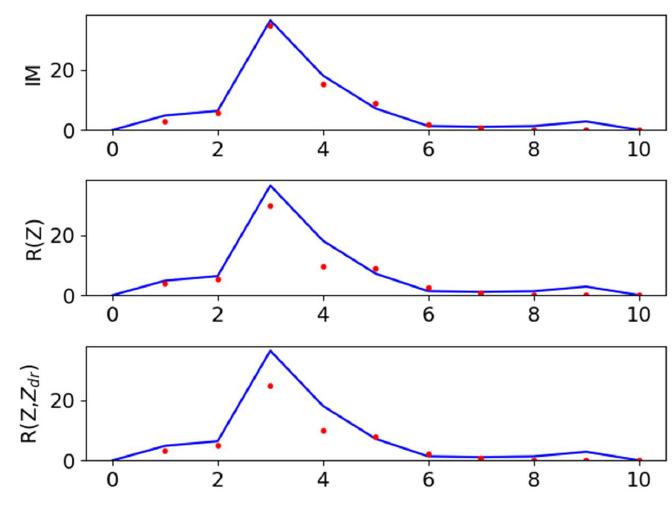
Figure 15. Same as Figure 14, but for one-hour rainfall accumulation.